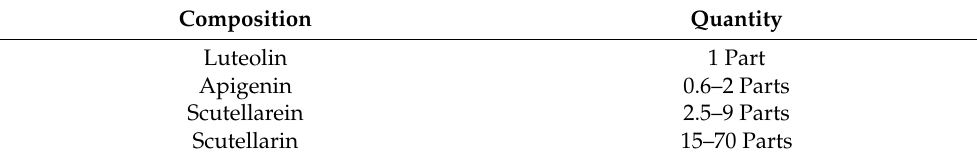
Table 1. Composition of Cohen’s patent [155] luteolin formulation as an anticancer agent.